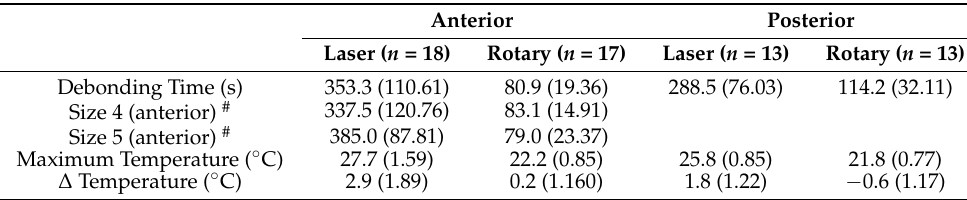
Table 1. Summary of Debonding Time, Maximum Temperature, and Temperature Change with Laser and Rotary Handpiece Crown Removal